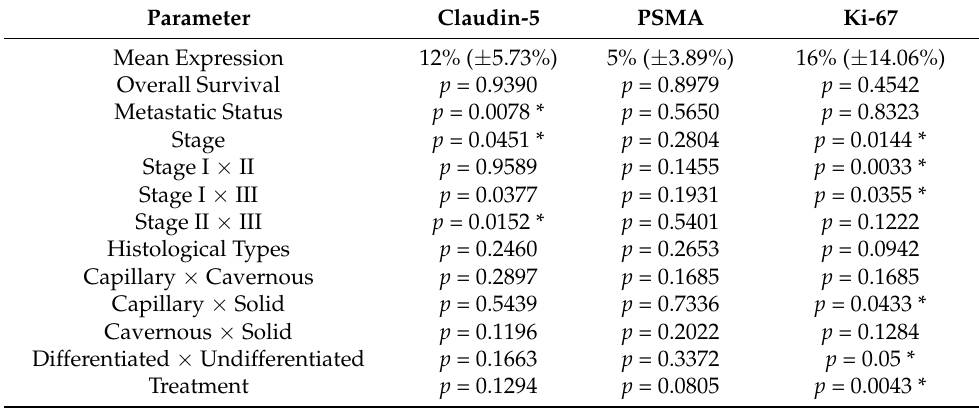
Table 2. Association of the different proteins with clinicopathological parameters.